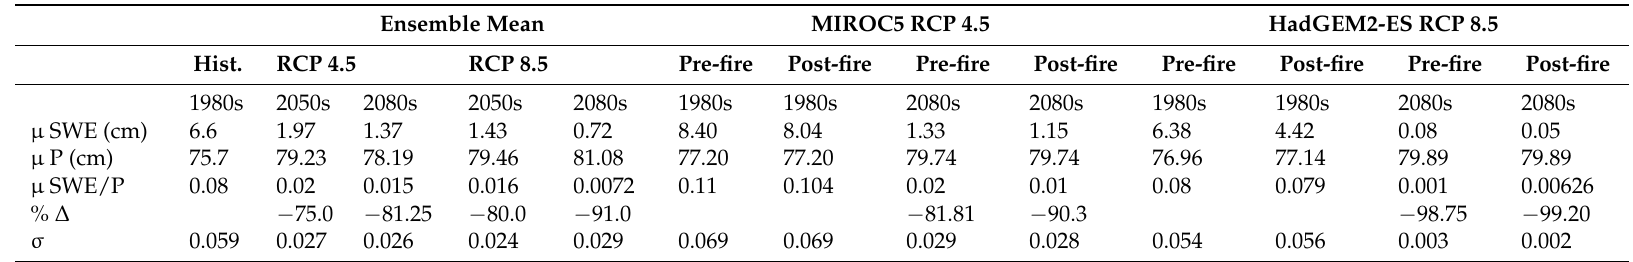
Table 6. Ensemble mean of snow water equivalent to precipitation (SWE/P) before forest cover reduction, and SWE/P before and after forest cover reduction